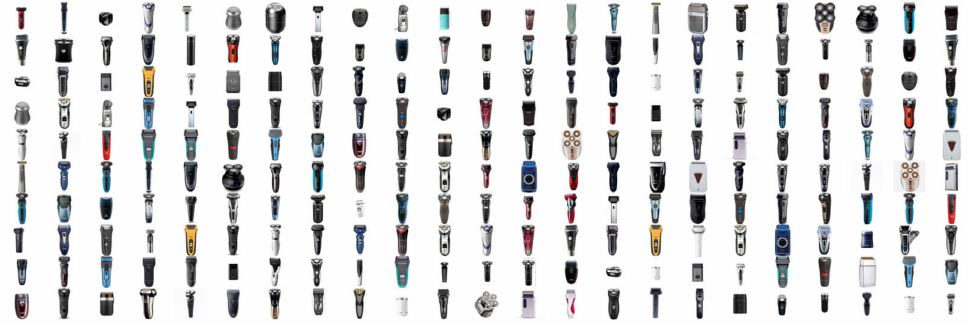
Figure 2. Collection of 230 electric shaver